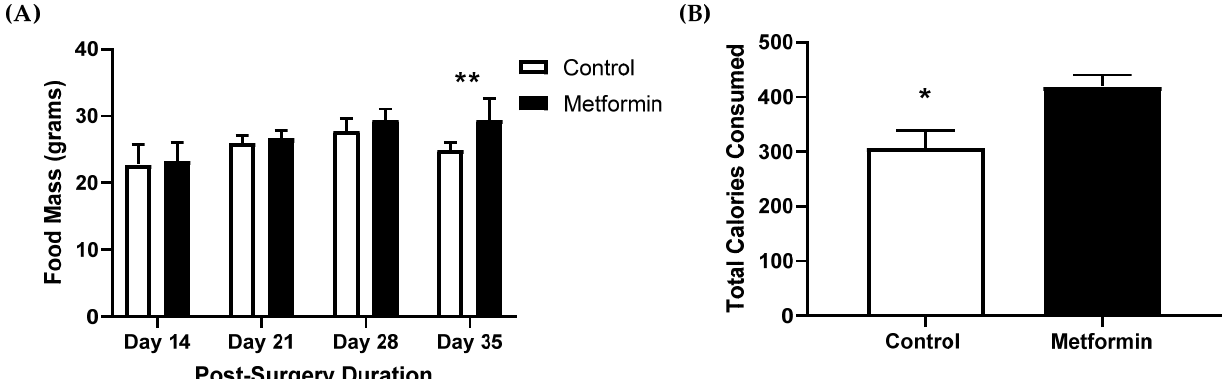
Figure 3. Total food mass and caloric consumption in C57BL/6J male and female mice following orthotopic LL/2 non-small lung cancer cell implantation. ( A ) Food consumption (grams) between control and treatment mice following tumor injection. Data were analyzed using mixed modeling (time × treatment). ** p = 0.009, main effect for time compared to Day 14. Control, n = 7; metformin, n = 8. Data shown as mean ± SEM. ( B ) Caloric Consumption between control and metformin- (250 mg/kg) treated mice following orthotopic LL/2 implantation. Data were analyzed using an unpaired t -test. * p = 0.018 compared to metformin animals. Control, n = 7; metformin, n = 8. Data shown as mean ± SEM.